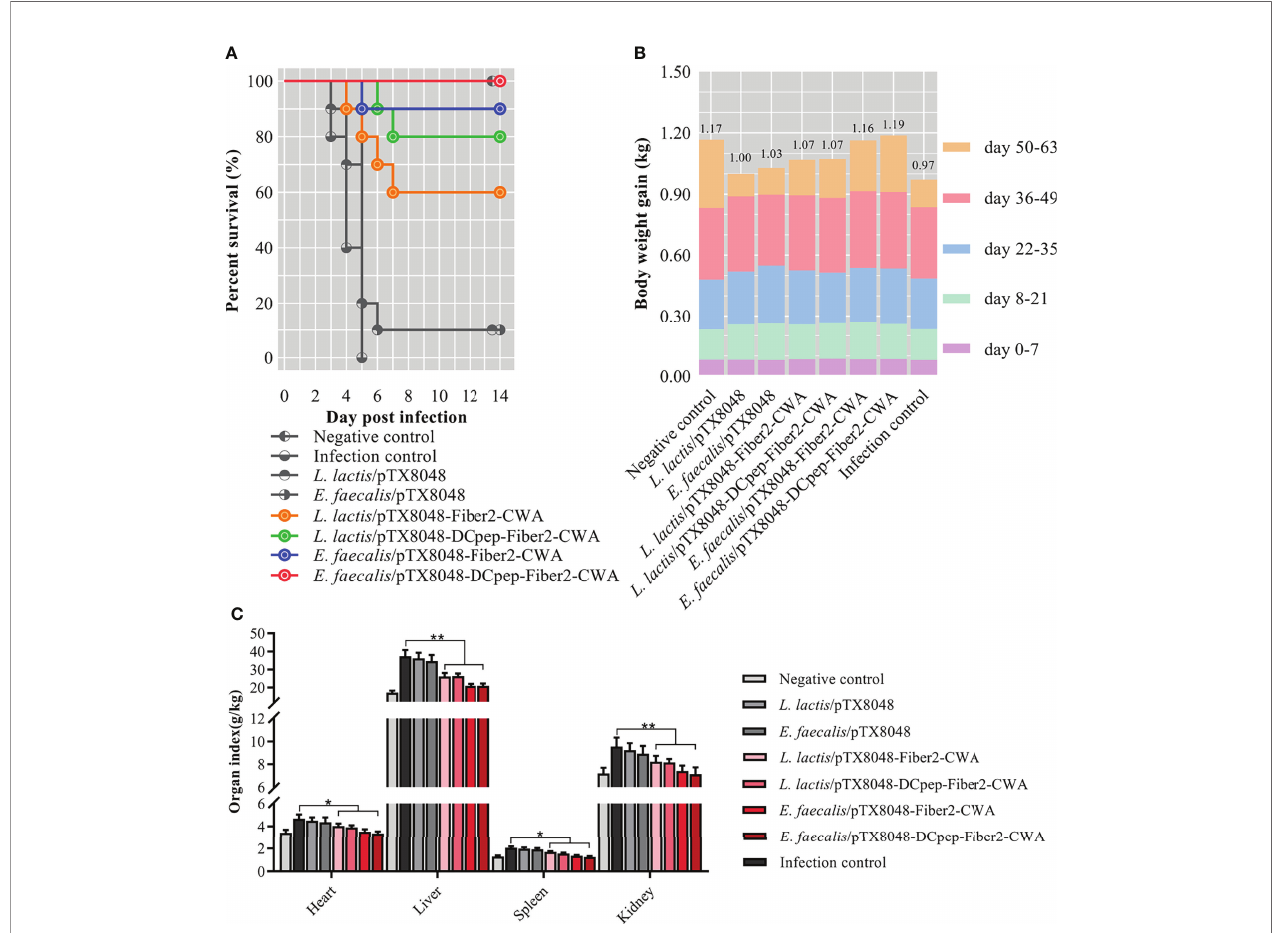
FIGURE 9 | Survival rate, body weight, and relative organ index of chickens. The survival rate (A) of chickens in each group was recorded within 2 weeks after the challenge with the highly virulent strain FAdV-4/GS01. Colored lines (A) represent groups immunized with live recombinant probiotics. The body weight gain of chickens (n = 10) in each group at each stage was shown by different colors, and the numbers at the top of the columns indicated each fi nal average body weight in each group (B) . The organ index of hearts, livers, spleens, and kidneys of chickens from each group was calculated (C) . * p < 0.05, ** p <